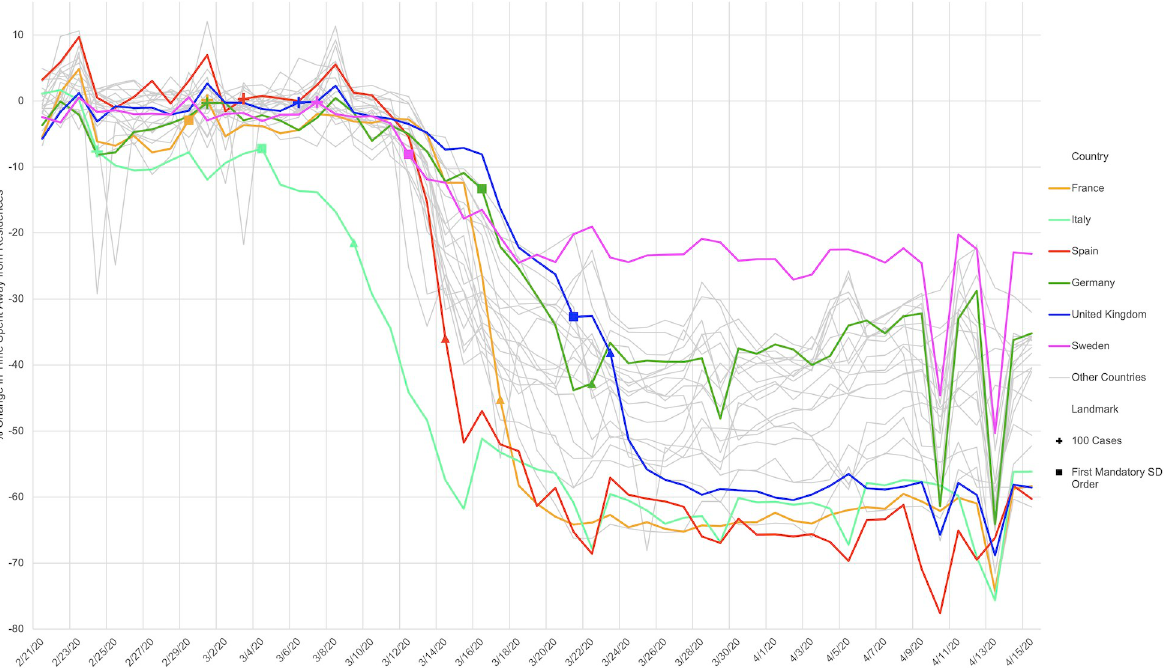
Fig 2. Relative change in mobility across study countries, Spring 2020. Relative change in mobility in European study countries, as estimated using aggregated (anonymized with differential privacy) data from Google users who have opted-in to Location History. For each country, crosses indicate the date on which the 100th case was reported, squares indicate the date of the first mandatory social distancing policy, and triangles denote the date of shelter-in-place orders.